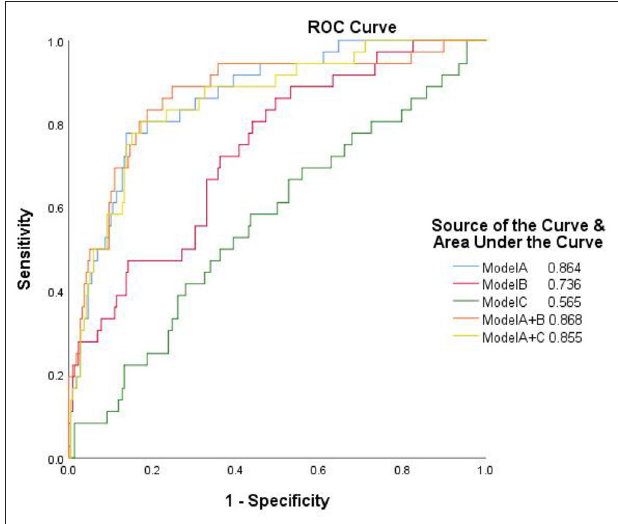
FIGURE 6 | The receiver operator characteristic curves of the separate and integrated models. Model A, model of traditional morphological features; Model B, model of Radiomics derived features; Model C, model of Radiomics derived morphological